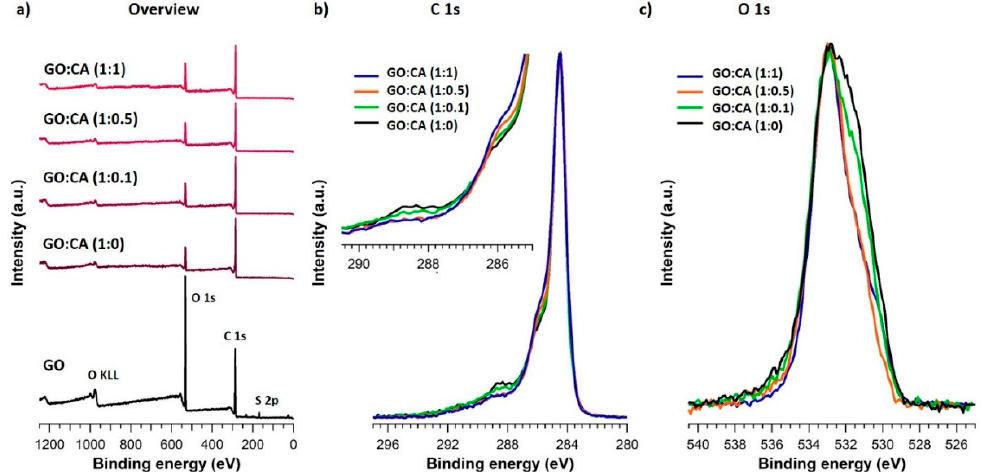
Figure 7. ( a ) XPS wide scans of hydrothermally reduced samples compared to GO. Normalized C 1s ( b ) and O 1s ( c ) high- resolution XPS spectra of the reduced samples. The upper inset of ( b ) shows a zoom-in of the key region of C 1s core